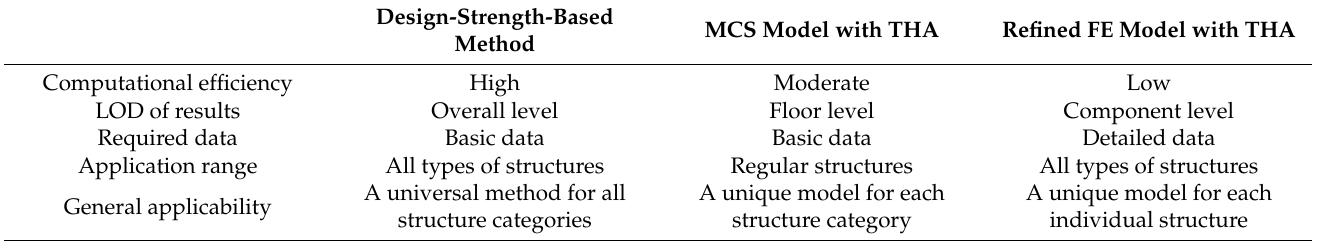
Table 4. Comparison of the proposed method, MCS model with THA, and refined FE model with THA.